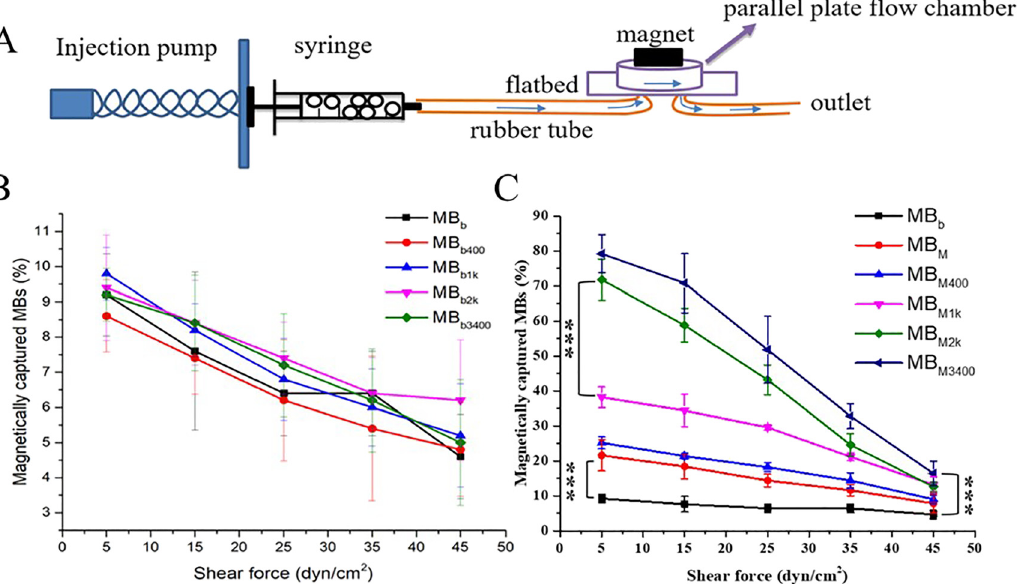
Figure 5: (A) Schematic of the home-made parallel plate flow chamber assay. The captured percentage of (B) biotinylated MBs and (C)magneticMBsbyanappliedmagnetic fi eld( B ≈ 1.2T)undersheerforcesfrom5to45dyn/cm 2 .ThebiotinylatedMBswereusedasacontrol. Data represent mean ± SD, n = 5. * p < 0.05, ** p < 0.01, *** p <